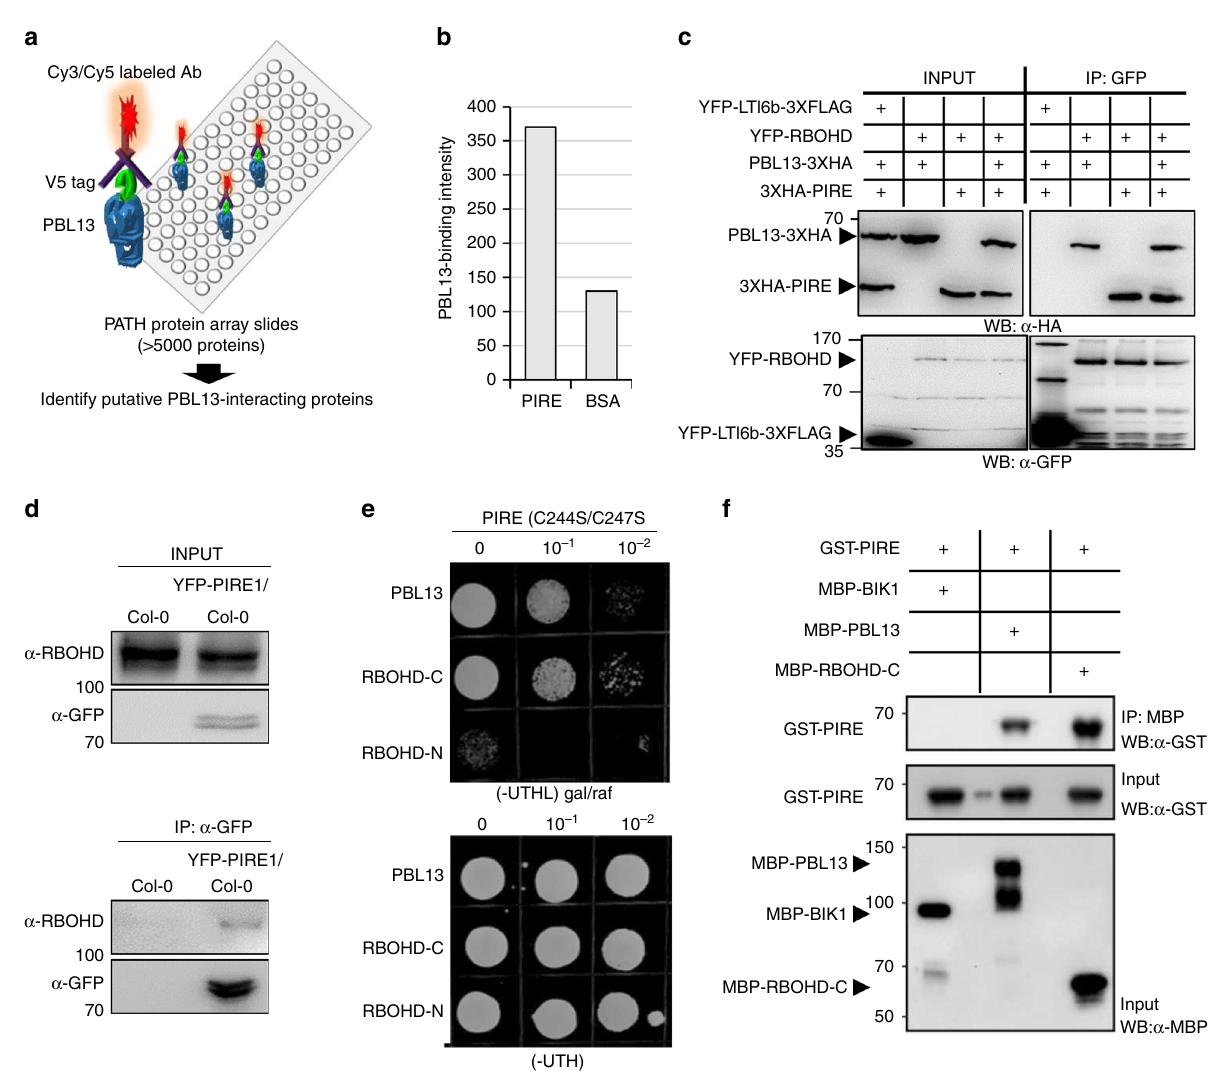
Fig. 3 PBL13-interacting RING type E3 ubiquitin ligase (PIRE) interacts with PBL13 and RBOHD. a Schematic representation of the Arabidopsis protein microarray. The PATH protein microarray with ~5000 Arabidopsis proteins was probed once with V5-tagged PBL13. b Quanti fi cation of PIRE and control protein (BSA)-binding intensity on the PATH array. c RBOHD associates with both PIRE and PBL13. YFP-LTI6b, YFP-RBOHD, PBL13-3xHA, and 3xHA-PIRE were transiently expressed in N. benthamiana in the indicated combinations. YFP-tagged proteins were subjected to anti-GFP immunoprecipitation and associations were detected by immunoblotting. d PIRE associates with RBOHD in Arabidopsis. Microsomal fractions were isolated from Col-0 or an Arabidopsis transgenic line expressing YFP-PIRE and subjected to co-immunoprecipitation using anti-GFP. e PIRE interacts with RBOHD-C and PBL13 by yeast two-hybrid assay. Serial dilution of yeast cells containing the indicated plasmids were spotted on -UTHL medium plates. The catalytic dead mutant of PIRE C244S/C247S was in the pTBS1 (bait) plasmid. PBL13, RBOHD-C, and RBOHD-N were screened for interaction with pTBS1-PIRE C244S/C247S . -UTHL, SD medium lacking uracil, tryptophan, histidine, leucine with galactose (gal) and raf fi nose (raf) as a sugar source. f PIRE directly interacts with PBL13 and RBOHD-C. Puri fi ed recombinant MBP-RBOHD-C, MBP-BIK1, or MBP-PBL13 were incubated with GST-PBL13 and pulled-down with GST agarose. Protein input and pulled-down products were analyzed by